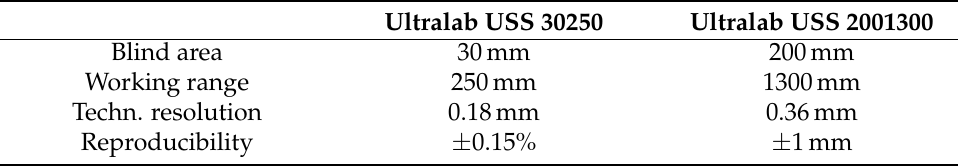
Table A1. Technical details of the applied us